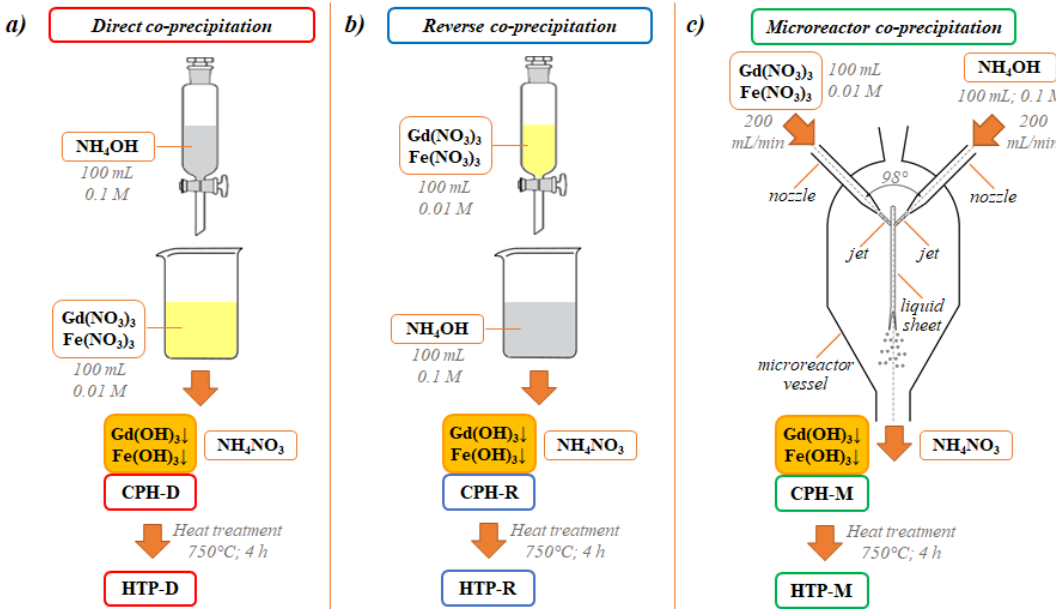
Figure 1. Scheme for the synthesis of co-precipitated hydroxides (CPHs) and their heat-treated products (HTPs): ( a ) direct co-precipitation (D); ( b ) reverse co-precipitation (R); ( c ) microreactor co-precipitation (M)